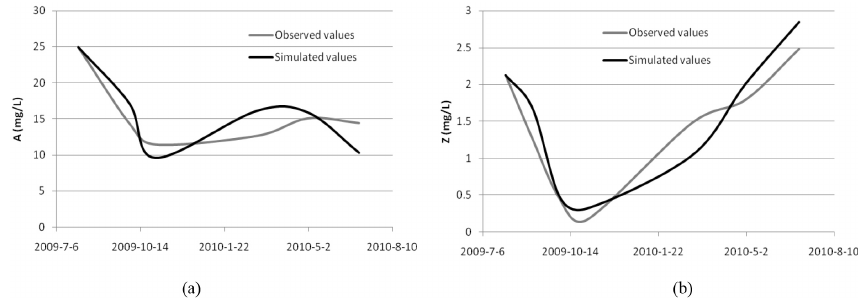
Figure 15. Calibration results for phytoplankton biomass (a) and zooplankton biomass (b) at site 12.